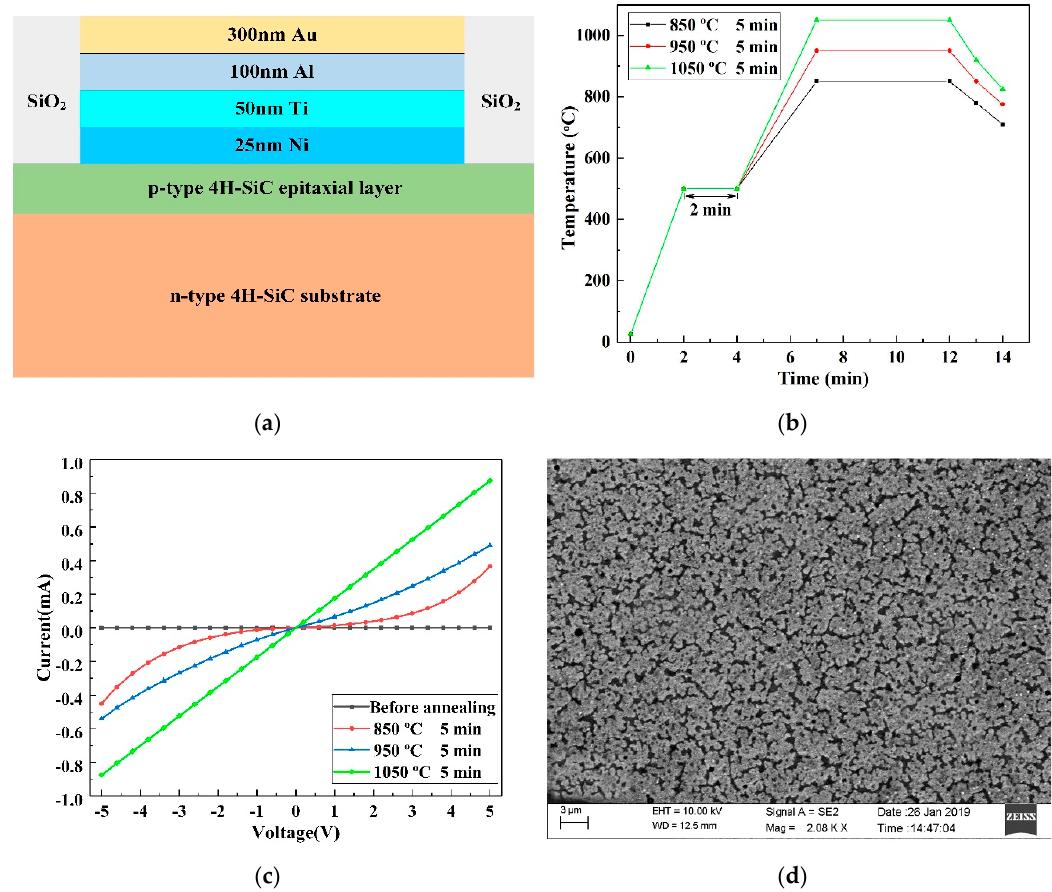
Figure 4. ( a ) The metal hierarchy inside the ohmic contact hole. ( b ) Temperature profile of the annealing process. ( c ) Current–voltage characteristics of the Ni/Ti/Al/Au and p-type 4H-SiC